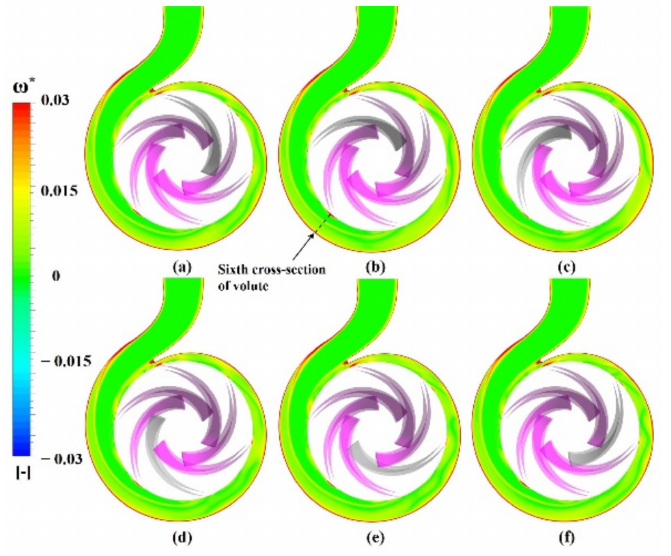
Figure 9. Spatial and temporal evolution of the vorticity under Q b operation conditions. ( a ) 0 T;